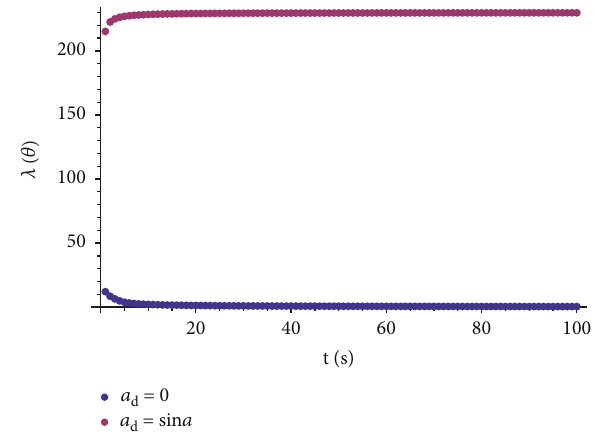
Figure 7: Pitch angle simulation with/without coupling